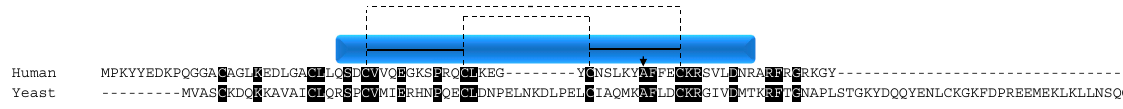
Figure 7. COA5/Pet191p. Alignment of human COA5 and yeast Pet191p protein sequences. Black boxes indicate conserved residues. Human sequence annotation is as follows: Blue box indicates the CHCH domain. Solid black lines indicate the CX 9 C-CX 10 C motif. Dashed lines indicate the cysteine pairs that form structural disulfide bonds.